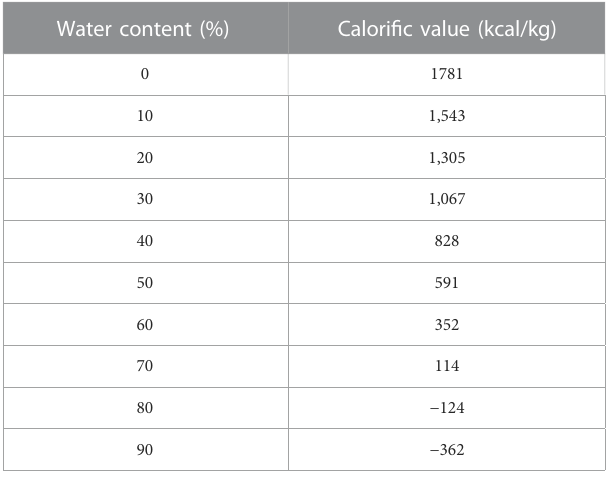
TABLE 3 The relationship of water content and calori fi c value (Li et al.,